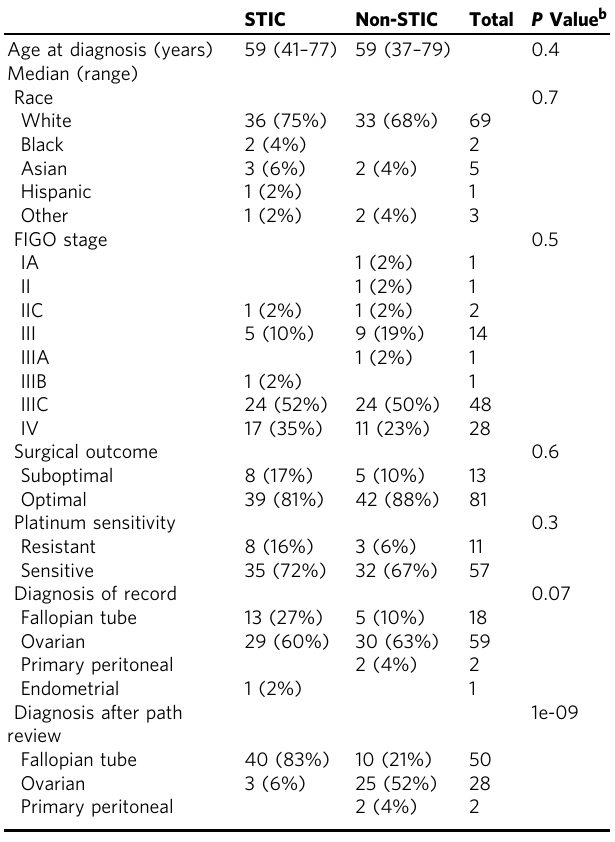
FIGO International Federation of Gynecology and Obstetrics, Non-STIC no serous tubal intra- epithelial carcinoma, STIC serous tubal intra-epithelial carcinoma a Numbers do not sum to the total of the study population for some variables due to missing values b Fisher ’ s exact